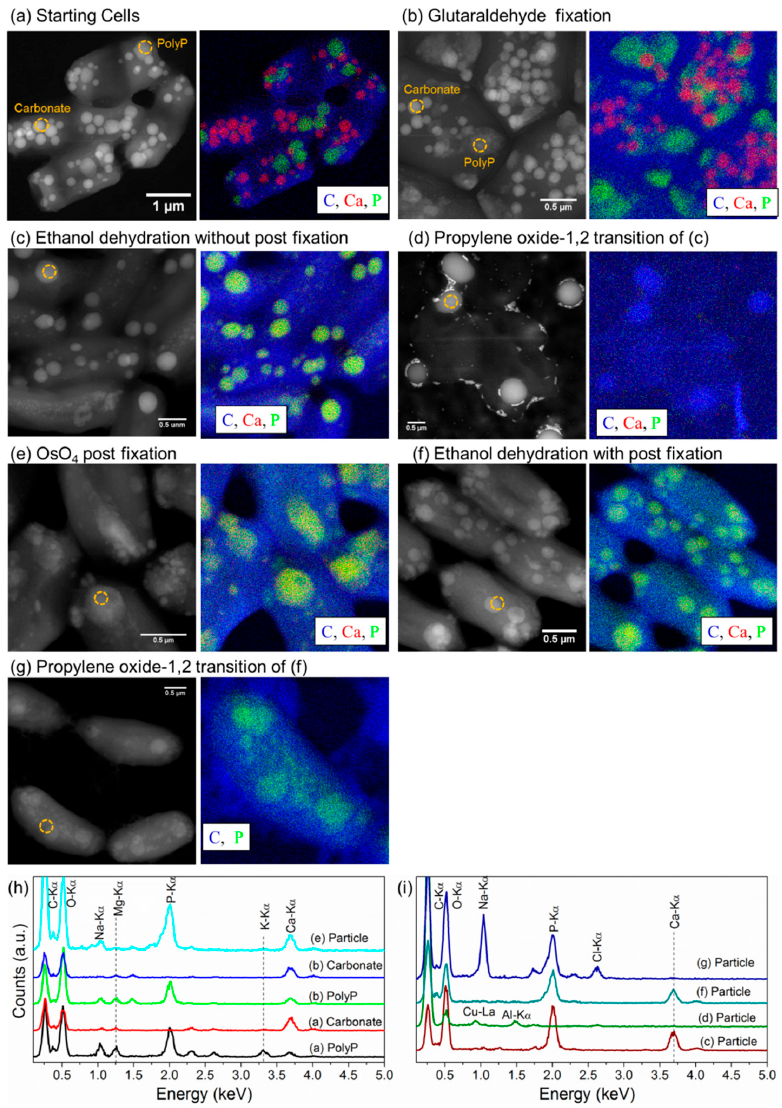
Figure 11. Chemical alterations of carbonate inclusions within Ca . G. lithophora C7 during